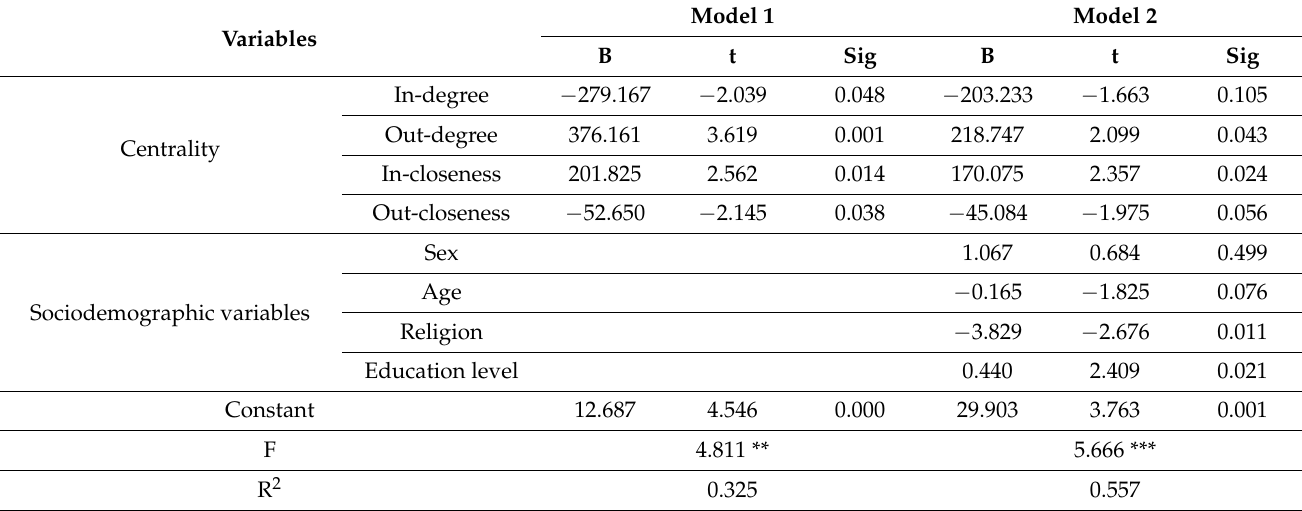
Table 4. Social network characteristics and sociodemographic